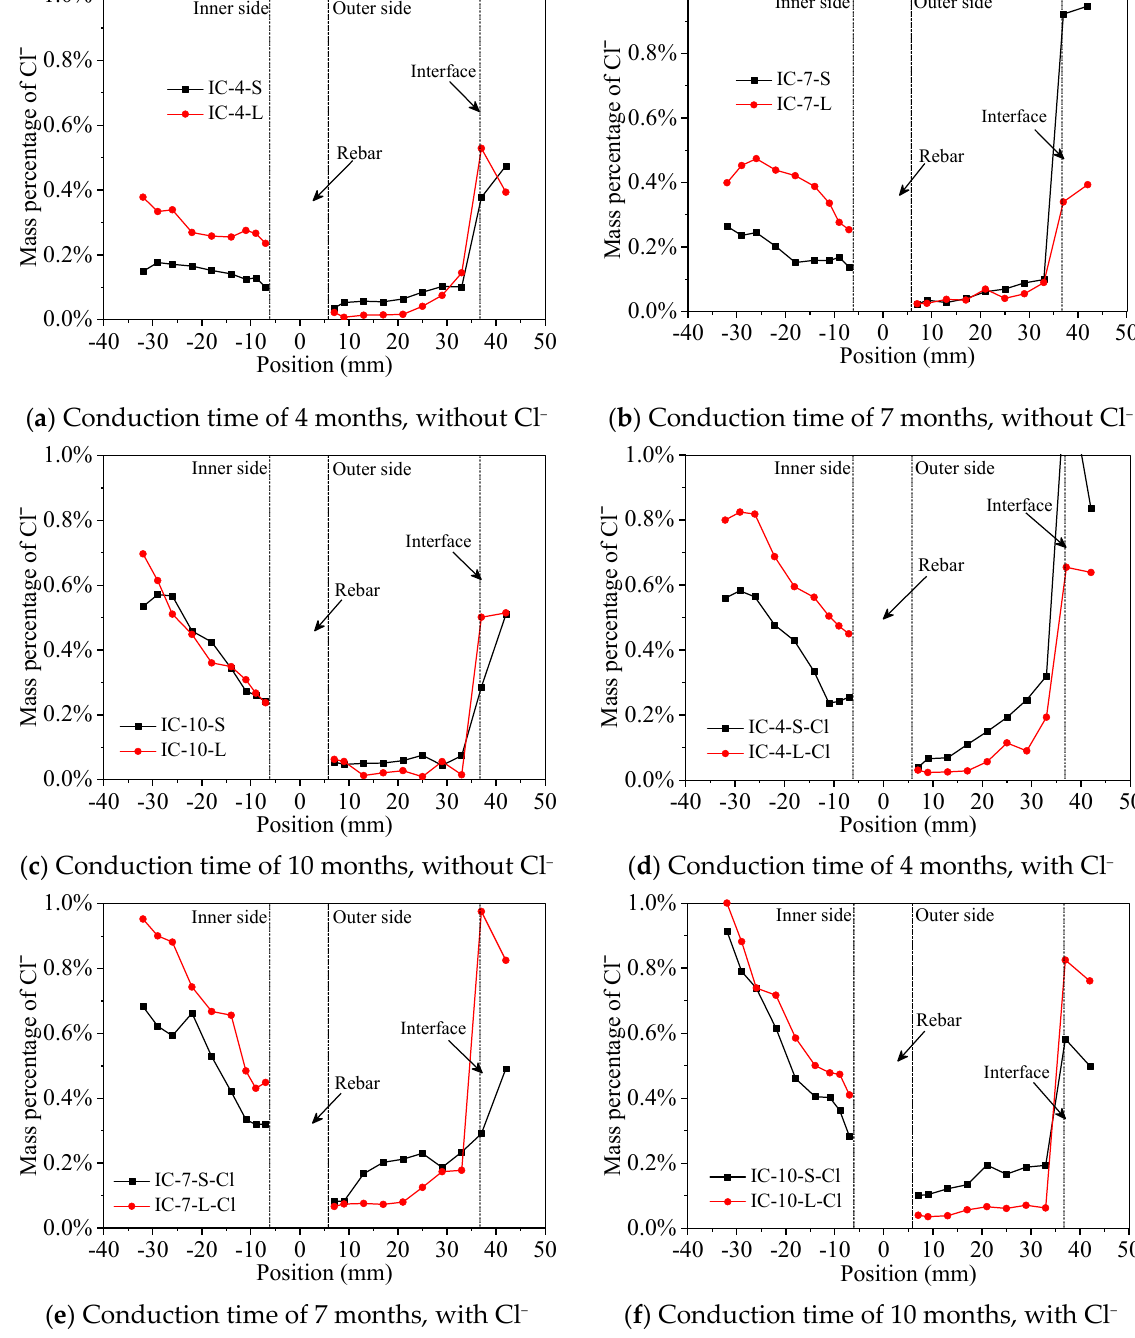
Figure 12. Influence of different current densities on the Cl − content at both sides of rebars. Overall, in the regions on the inner side of the rebar (x < 0 mm), a larger current density usually lead to higher Cl − content, which may have a negative impact on rebars; however, this negative impact gradually diminished with the increase of conduction time. In the regions on the outer side of the rebar (x > 0 mm), a larger current density usually lead to a better migration effect on Cl − ; that is, a larger current density plays a positive role for the protection of